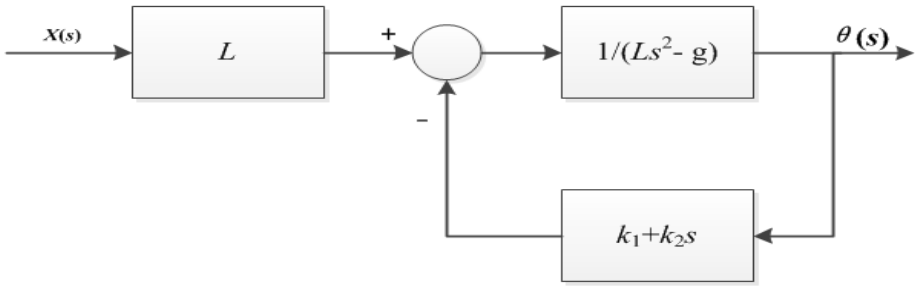
Figure 7. The original root locus of the robot.